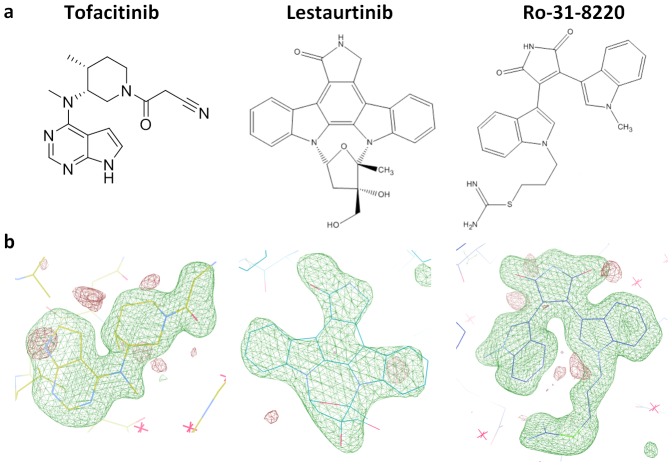
Chemical structures and electron density for PRK1 inhibitors discussed in this paper.1a, Chemical structures for PRK1 inhibitors. 1b, Difference electron density calculated at 3.5σ following REFMAC5 refinement in the absence of ligand.